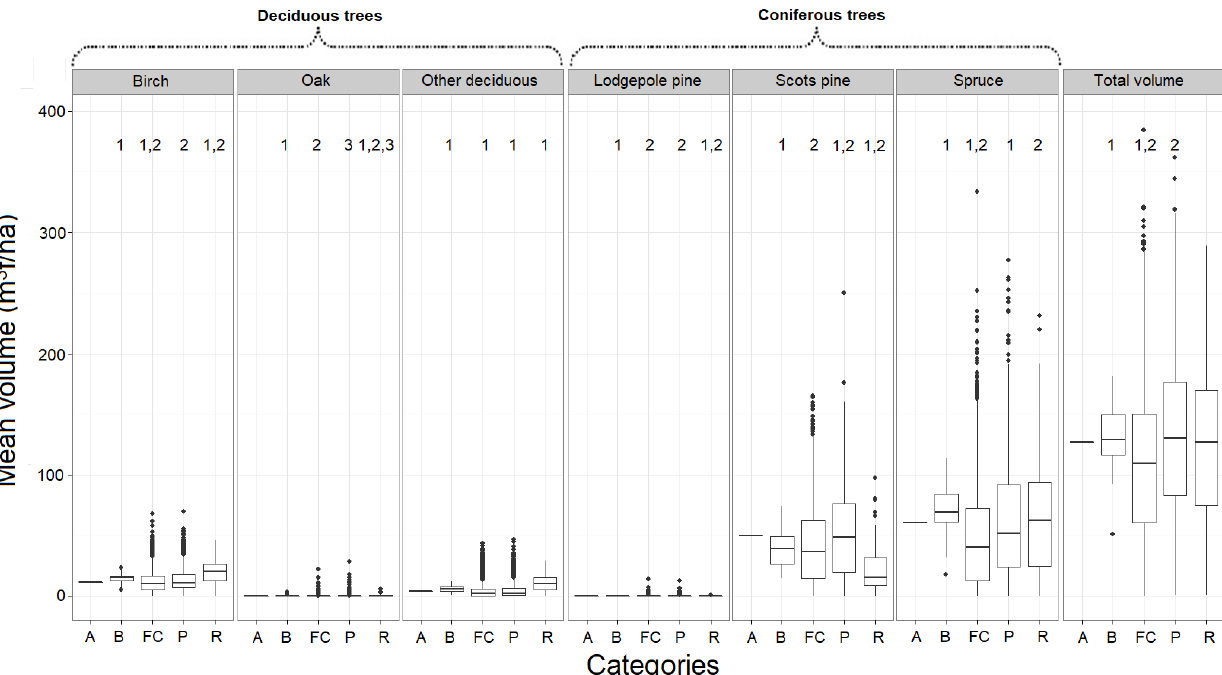
Figure 2. Boxplots of the mean volume in m 3 f/ha (cubic meter standing volume per hectare) in 2000, per A: entire study region, B: buffer zones around sites selected for restoration, FC: forest company owned land, P: protected areas, R: sites selected for restoration. Equal numbers displayed above bars denote significance between categories ( p ≤ 0.050).